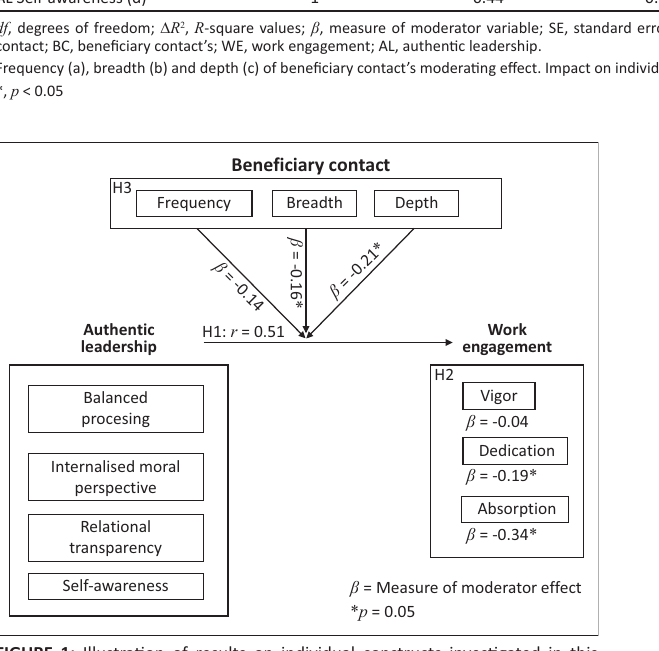
FIGURE 1: Illustration of results on individual constructs investigated in this